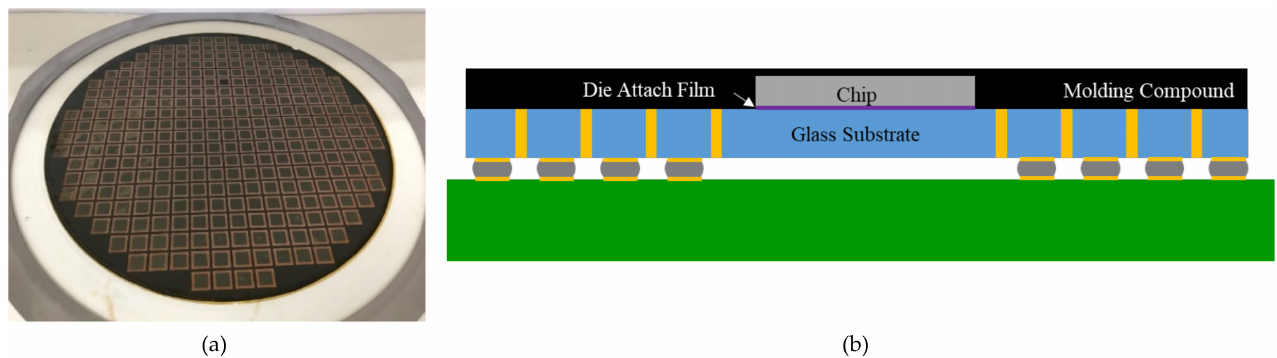
Table 1. In the test board, a daisy-chain structure was used to check the electrical resistance of the chained solder joints (Figure 3). The test vehicle was deemed to have failed if its daisy-chain resistance was infinite.